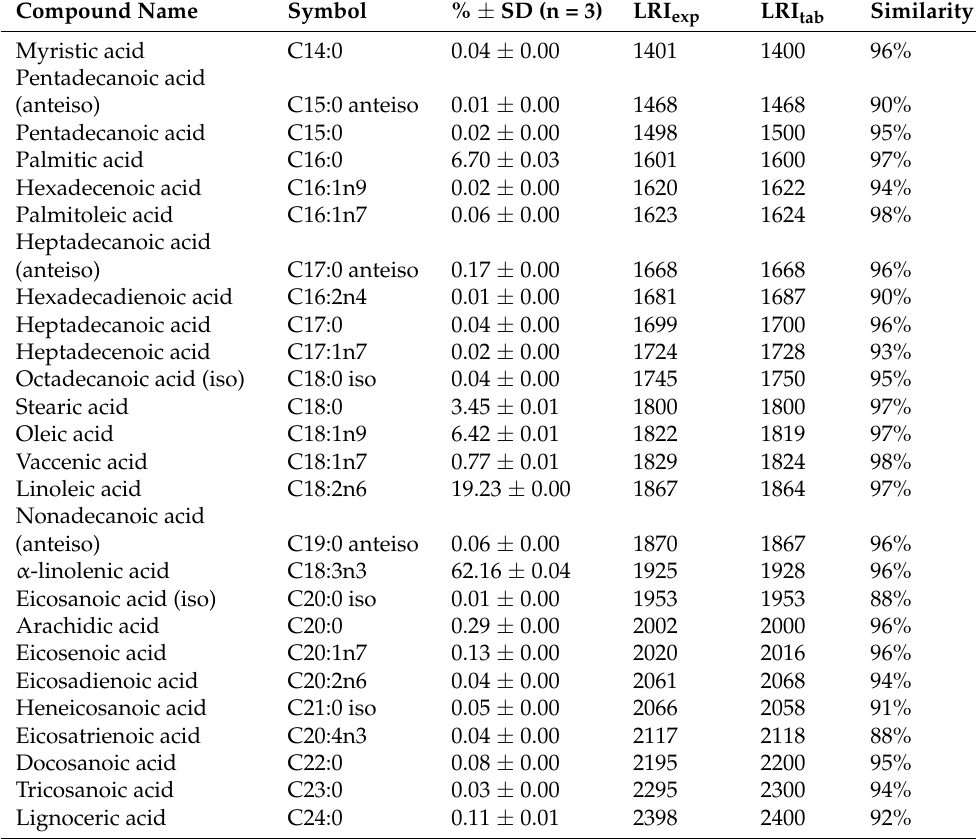
Table 1. Mean content of FAs in Chia seed oil, determined as FAMEs by GC-FID/MS, along with MS similarity and LRI values, compared to tabulated